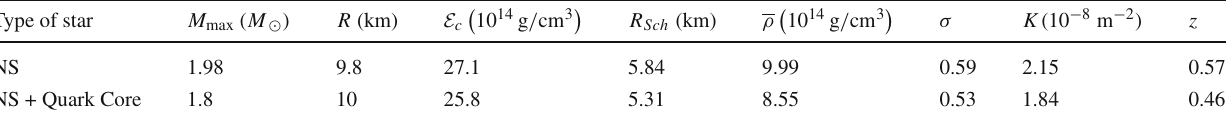
Table 2 Structure properties of neutron star without quark matter (NS) and with quark core (NS + Q) Type of